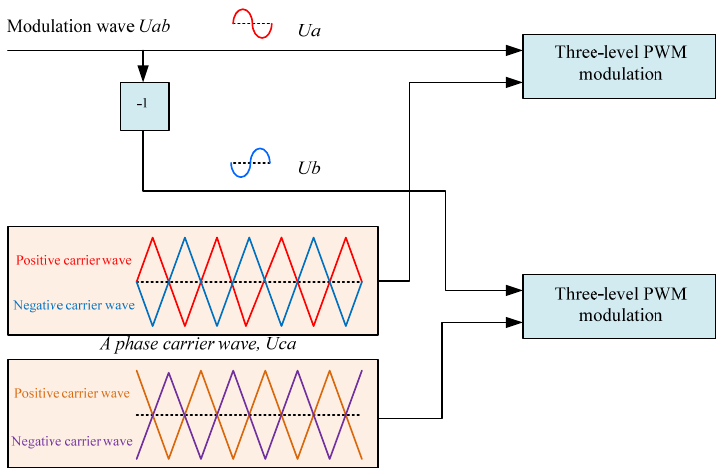
Figure 5. PWM modulation